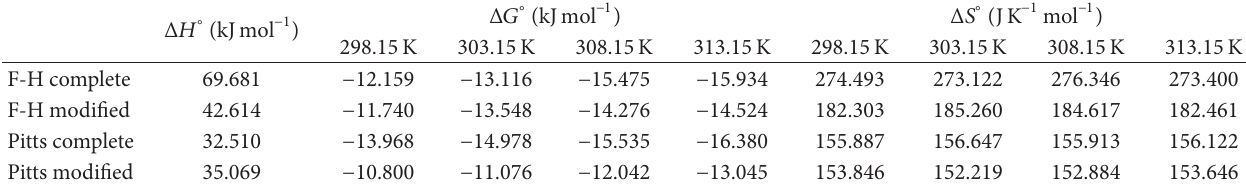
T 9: ermodynamic data for Ba-succinate.